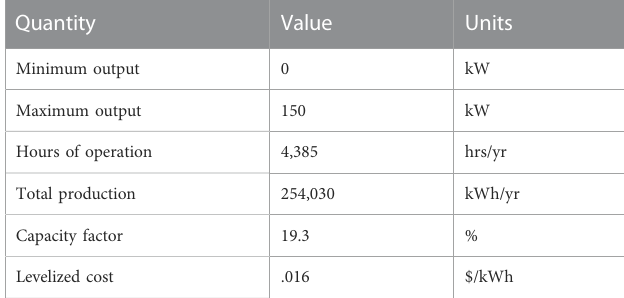
TABLE 6 Power production summary for the proposed